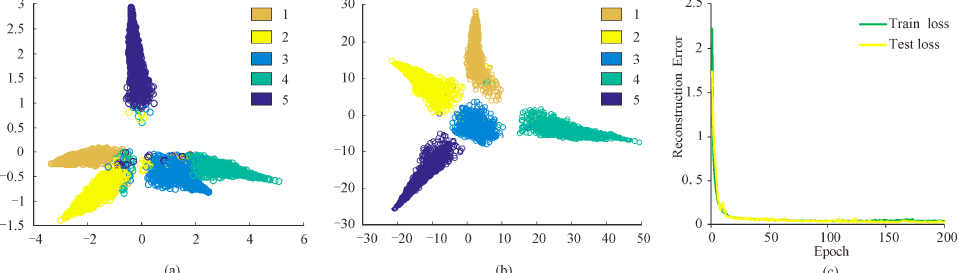
Figure 8. ( a ) The distribution of the original synthetic dataset; ( b ) the distribution of the latent vectors extracted from SSAAE; ( c ) the convergence process of reconstruction error on training and testing sets. Where the dimensionalities were reduced using PCA [56] and the different colors in ( a , b )